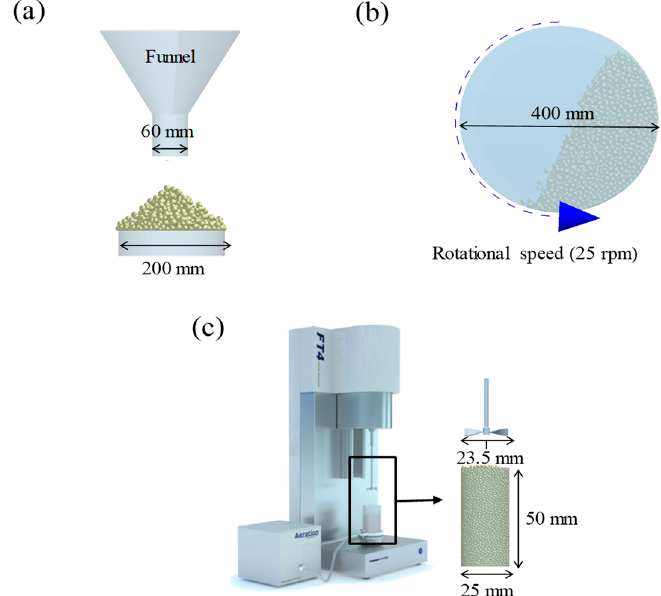
Figure 1. Illustration of geometry for calibration approach: ( a ) static angle of repose, ( b ) dynamic angle of repose (the blue arrow indicates the direction in which the rotating drum revolved), and ( c ) FT4 rheometer.